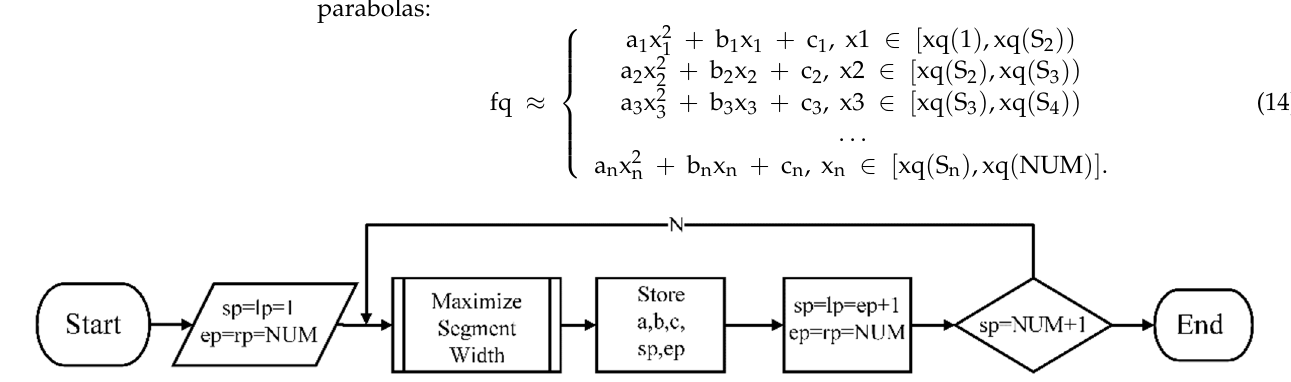
Figure 4. Segmentation process of the whole input range.